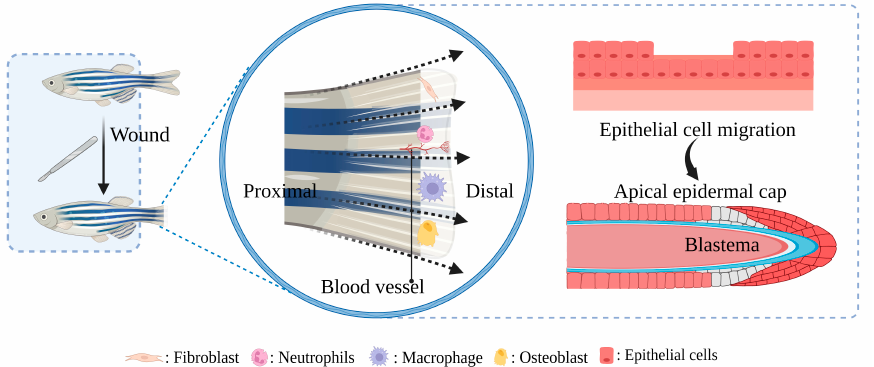
Figure 1. The role of participating in a zebrafish caudal fin regenerative wound healing model. Within 1–3 h-post-amputation (hpa), epithelial cells migrate to cover and close the wound. By 18–24 hpa, an apical epidermal cap is formed, and a mass of undifferentiated mesenchymal cells called the blastema accumulates underneath the apical epidermal cap. At 24 hpa the blastema cells segregate into two morphologically indistinct compartments: a slowly proliferating distal blastema and a rapidly proliferating proximal blastema. After 48 hpa the regeneration program is installed and the regenerative outgrowth continues until the original tissue architecture is reconstituted.